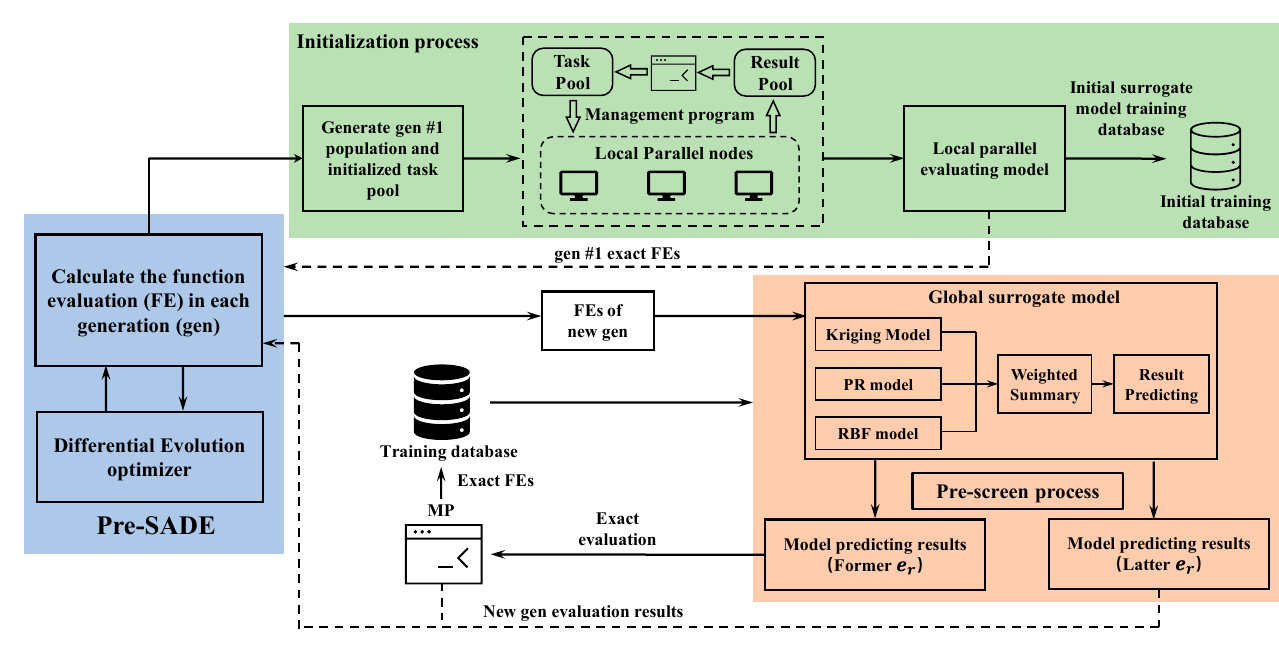
Figure 2. The diagram of pre-SADE (the green box indicates the initial process, and only executes once at the start of pre-SADE; the blue box shows the diagram of DE; and the orange box denotes the surrogate model and the pre-screen